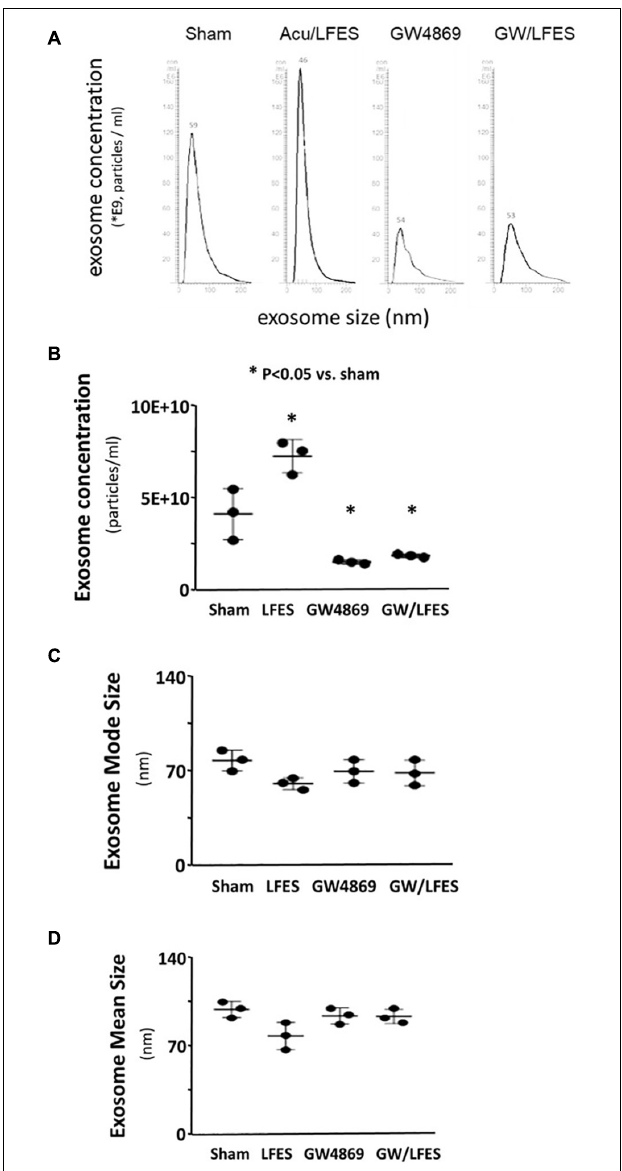
FIGURE 2 | GW4869 limited exosome secretion. Exosomes were isolated from sham, Acu/LFES, GW4869 and Acu/LFES+GW4869 treated mice. The exosome distribution (A) , concentration (B) , mode size (C) and mean size (D) were measured using a NanoSight instrument (means ± SE; n = 3/group; ∗ p < 0.05 vs.